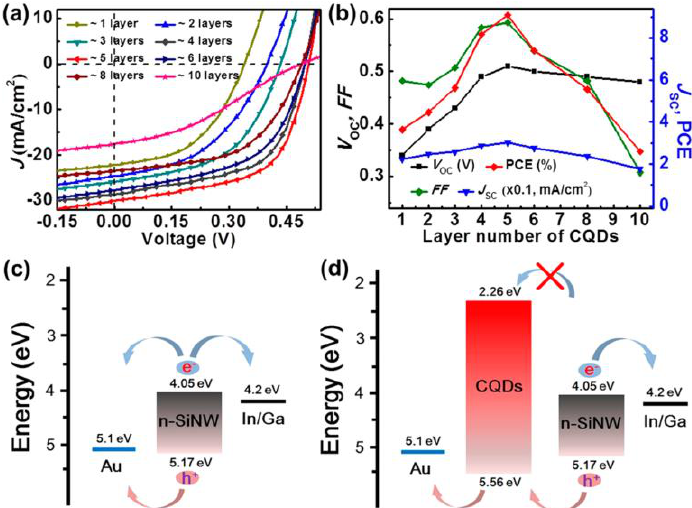
Figure 8. Variation of the JV curve ( a ) and cell parameters ( b ) with increasing layers of CDs; Energy level alignments of the cells without ( c ) and with ( d ) CDs. Reproduced with permission of [30].